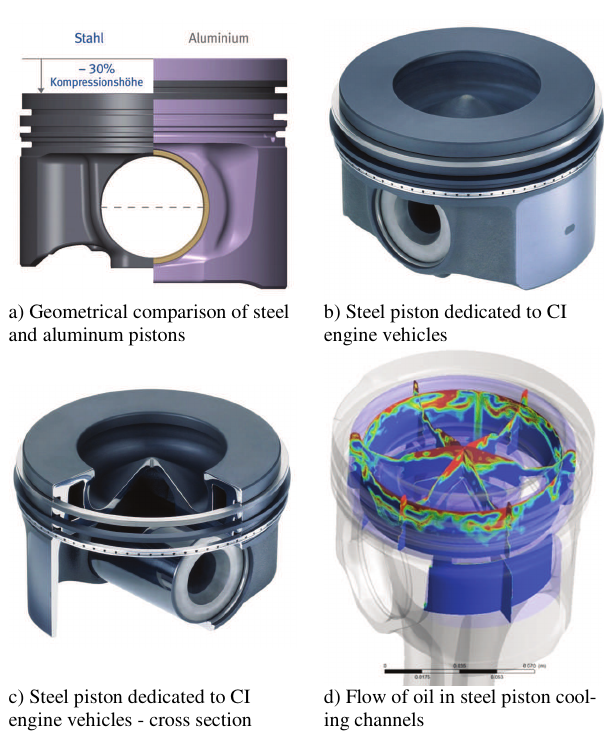
Fig. 3. Steel piston dedicated to diesel engines [20]